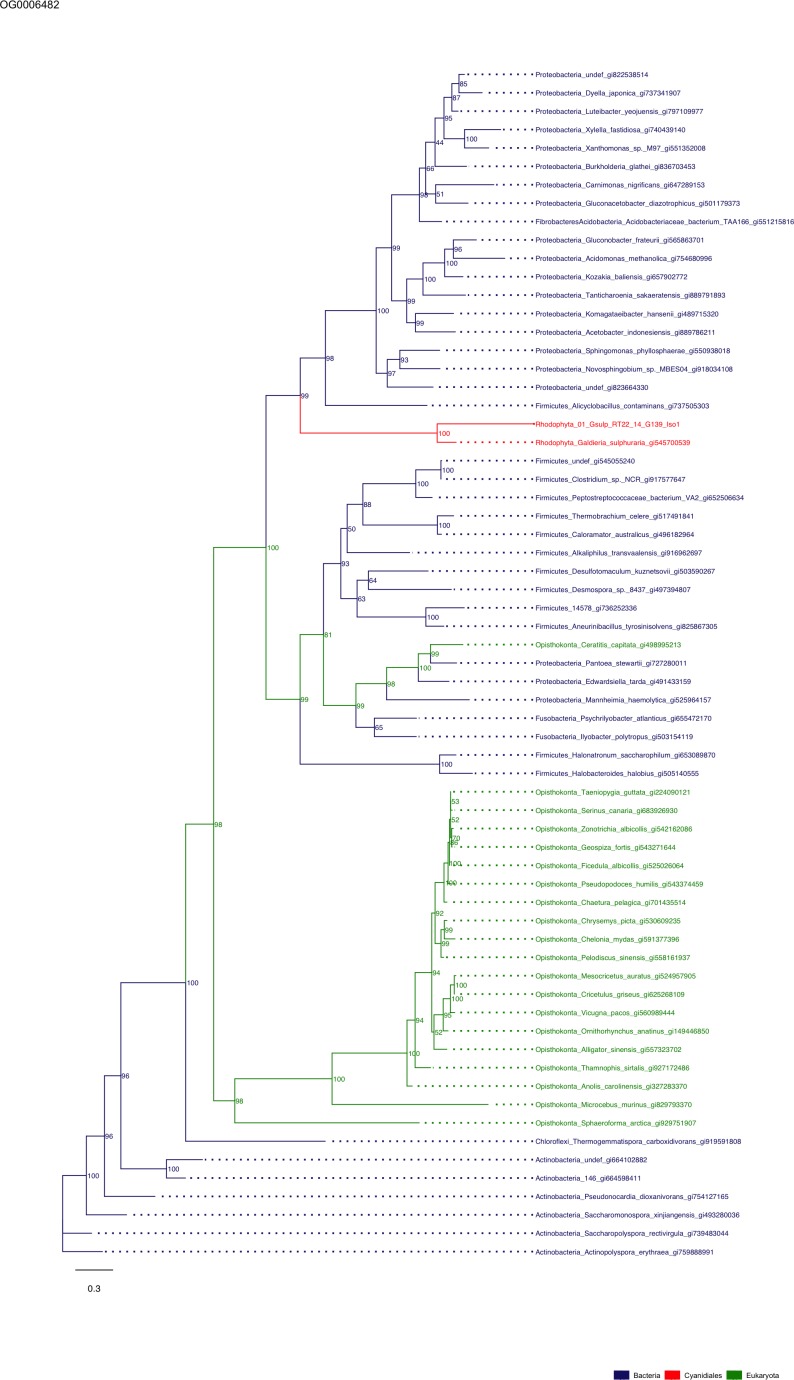
Sequence tree of orthogroup OG0006482.The tree is based on amino acid sequences. Archaea (yellow), Bacteria (blue), Cyanidiales (red), Eukaryotes including other red algae (green). Branches containing Cyanidiales sequences are highlited in red.